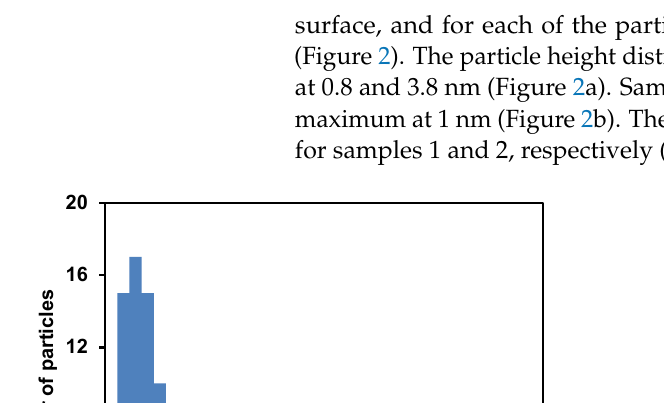
Figure 1. Topographic images of β -CN nanoparticles digested with trypsin for 90 min, followed by